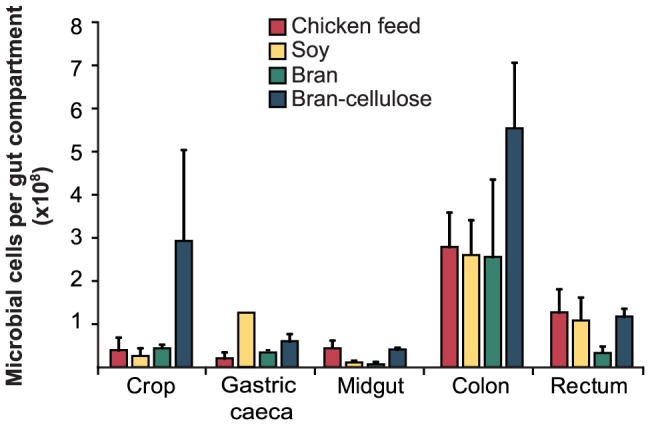
Enumeration of microbial cells within each gut compartment of individual cockroaches fed different diets.Deviations are given as standard error of the mean (n = 3).